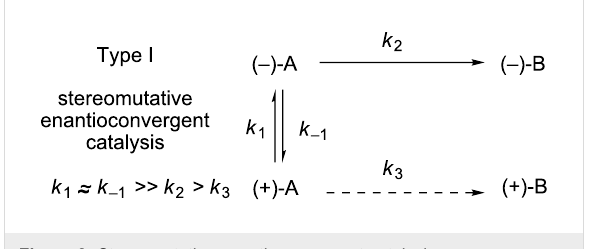
Figure 2: Stereomutative enantioconvergent